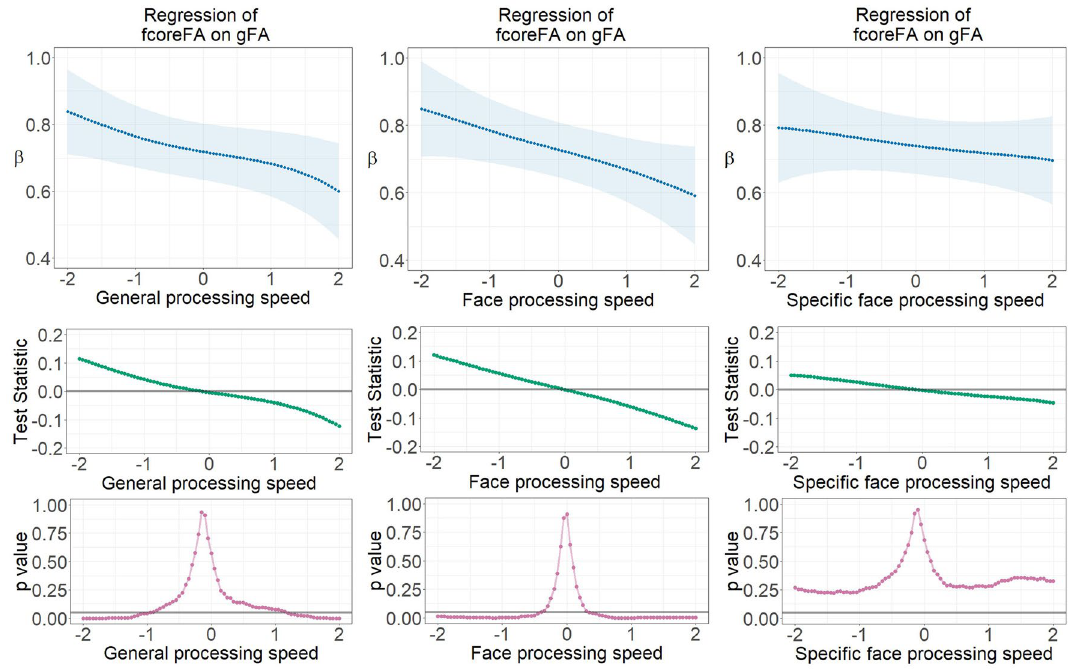
Figure 3. Parameter gradients indicating regressions of fcoreFA on gFA across continuously assessed processing speed ability scores using LSEM, namely (1) general processing speed ability, (2) face processing speed ability, and (3) specific face processing speed ability with general speed controlled for. The upper row displays variations of locally estimated FA factor regressions across processing speed ability scores—FA factor regression parameter functions. The middle row provides the course of the test statistic across processing speed ability scores as estimated with the permutation test. The bottom row displays the pointwise p -value curve, with p = .05 displayed as a threshold (see the gray horizontal line). β—Standardized regression weight; gFA— Fractional anisotropy in global brain fibers; fcoreFA—Fractional anisotropy of core face network